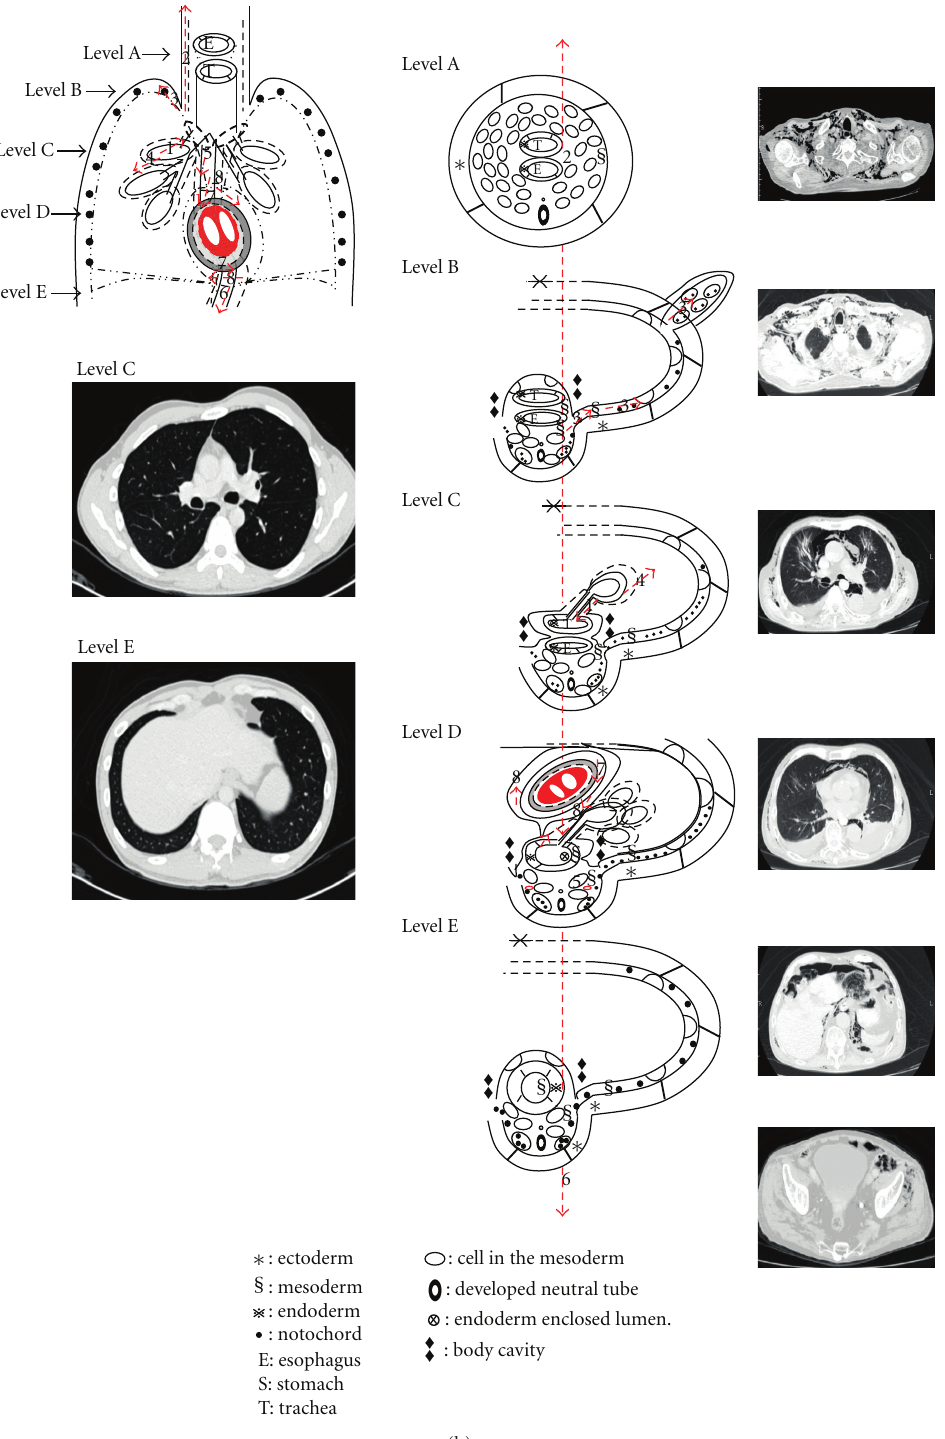
Figure 8: Air flow in the pneumomediastinum: peribronchial space (1); neck (2); chest wall (3); pleural cavity (4); mediastinum (5); retroperitoneum (6); pericardial cavity (7); paracardial space and diaphragm